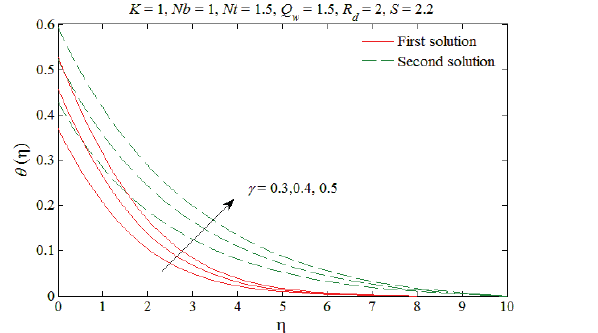
Fig. 11: The concentration profiles for different values of R d